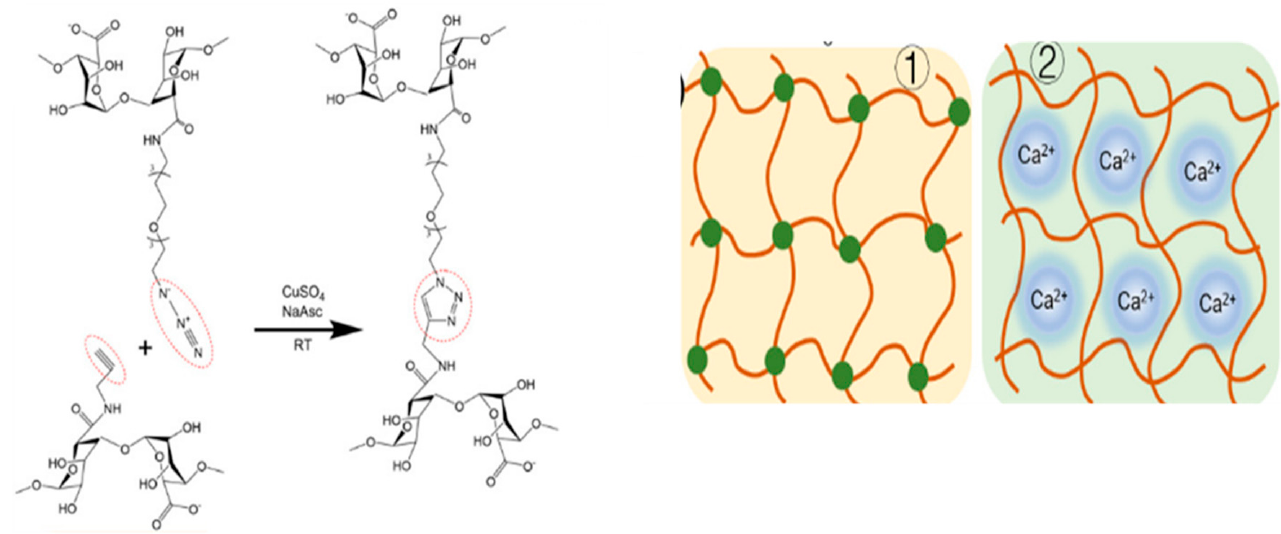
Figure 11. Schematic illustration for the Cu(I)-mediated cross-linking between P(NIPAAm- co -HEMA) and cellulose (adapted with permission from Zhang et al., 2009).